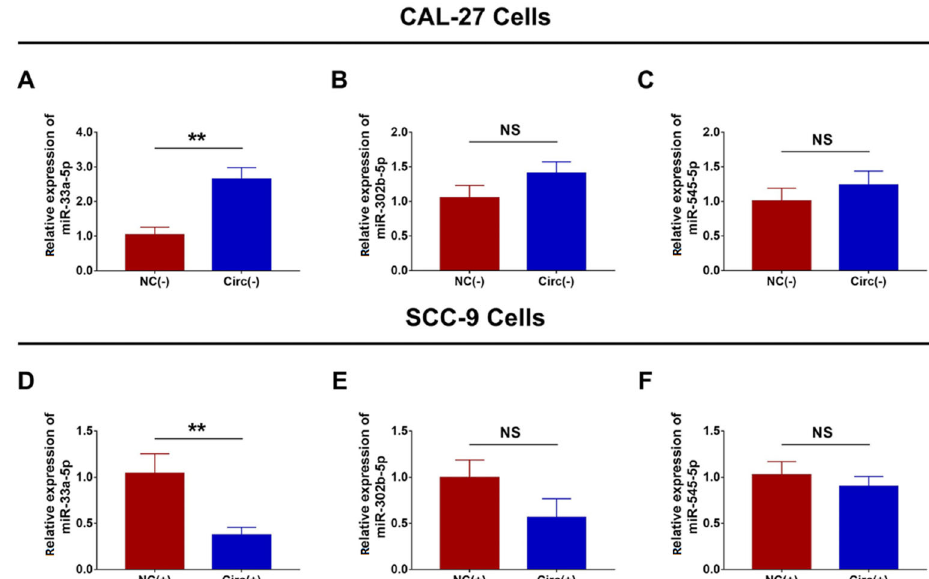
Figure 5. Comparison of A , miR-33a-5p, B , miR-302b-5p, and C , miR-545-5p expressions between the Circ( – ) group and the NC( – ) group. Comparison of D , miR-33a-5p, E , miR-302b-5p, and F , miR-545-5p expressions between the Circ( + ) group and the NC( + ) group. Hsa_circ_0002162 knock-down plasmid and circRNA control knock-down plasmid were transfected into CAL-27 cells and then divided into Circ( – ) cells and NC( – ) cells, accordingly. Hsa_circ_0002162 overexpression plasmid and circRNA control overexpression plasmid were transfected into SCC-9 cells and then divided into Circ( + ) cells and NC( + ) cells, accordingly. Data are reported as means ± SD. **P o 0.01 ( t -test). NS: not signi fi cant; miR: microRNA; Circ: circRNA; NC: negative control.